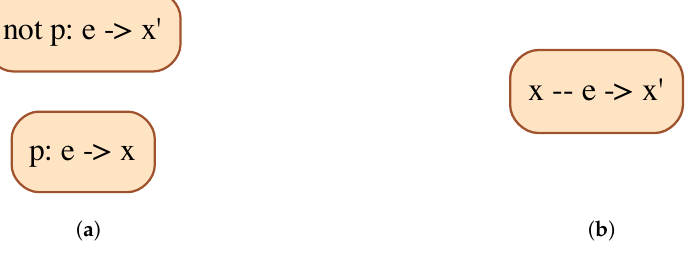
Figure 2. CDG and DG of the two-equation model from Figure 1. Vertices are conditional equation blocks of the form p : R E W , where: E is the block of equations; p is a Boolean condition, − → defining the set of modes in which the block has to be solved; R is a set of variables to read, or free variables, i.e., parameters of the block of equations; W is a set of variables to write, meaning that they are the unknowns of the block of equations. When R is empty, the shorthand notation is p : E When p is the constant T , prefix “ p :” is omitted. ( a ) CDG of the two-equation model, resulting from structural analysis.